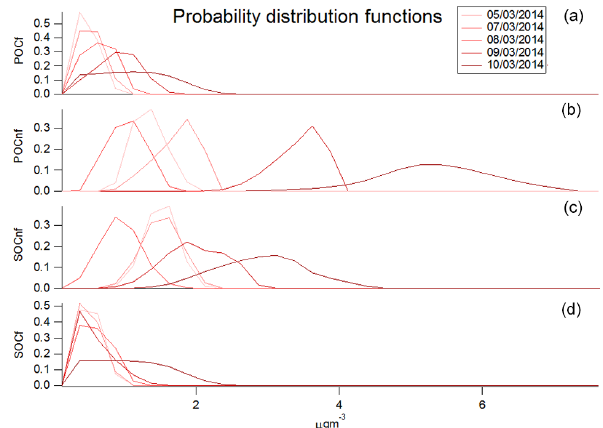
Figure 7. Probability distribution functions of the absolute daily contribution of POC f (a) , POC nf (b) , SOC nf (c) , SOC f (d) .